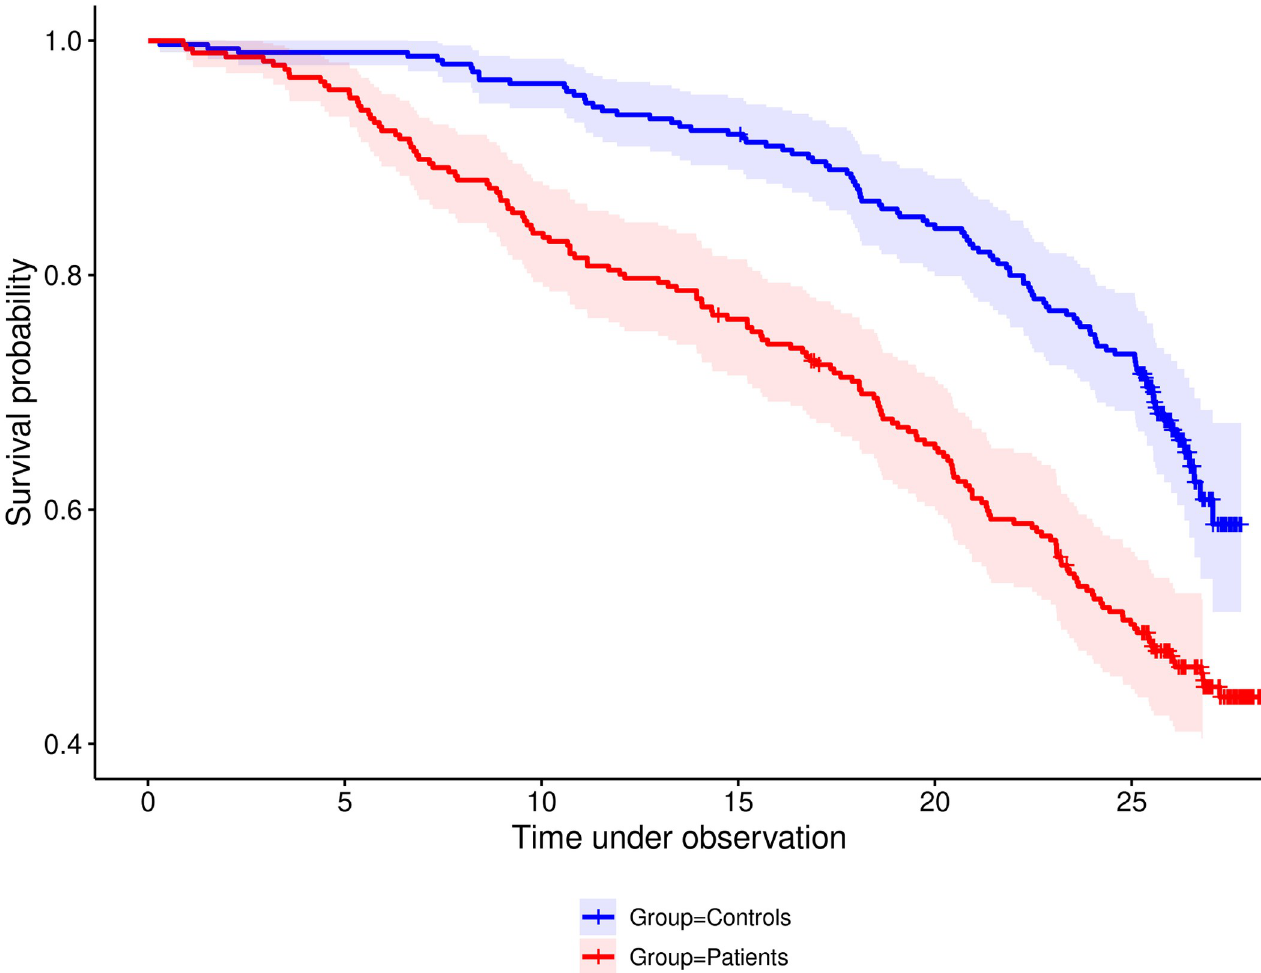
Fig 1. Survival in female CAD patients and healthy controls. Kaplan Meier estimates including 95% point wise CIs are displayed in red for patients and blue for controls. The difference is quite obvious. The chance for surviving 26 years of follow up is below 50% for patients, compared to almost 60% of healthy controls. Considering the time points for 75% survival we find a time shift of 8.4 years (approx. 95% CI 4.2–12.6) in favor of controls.